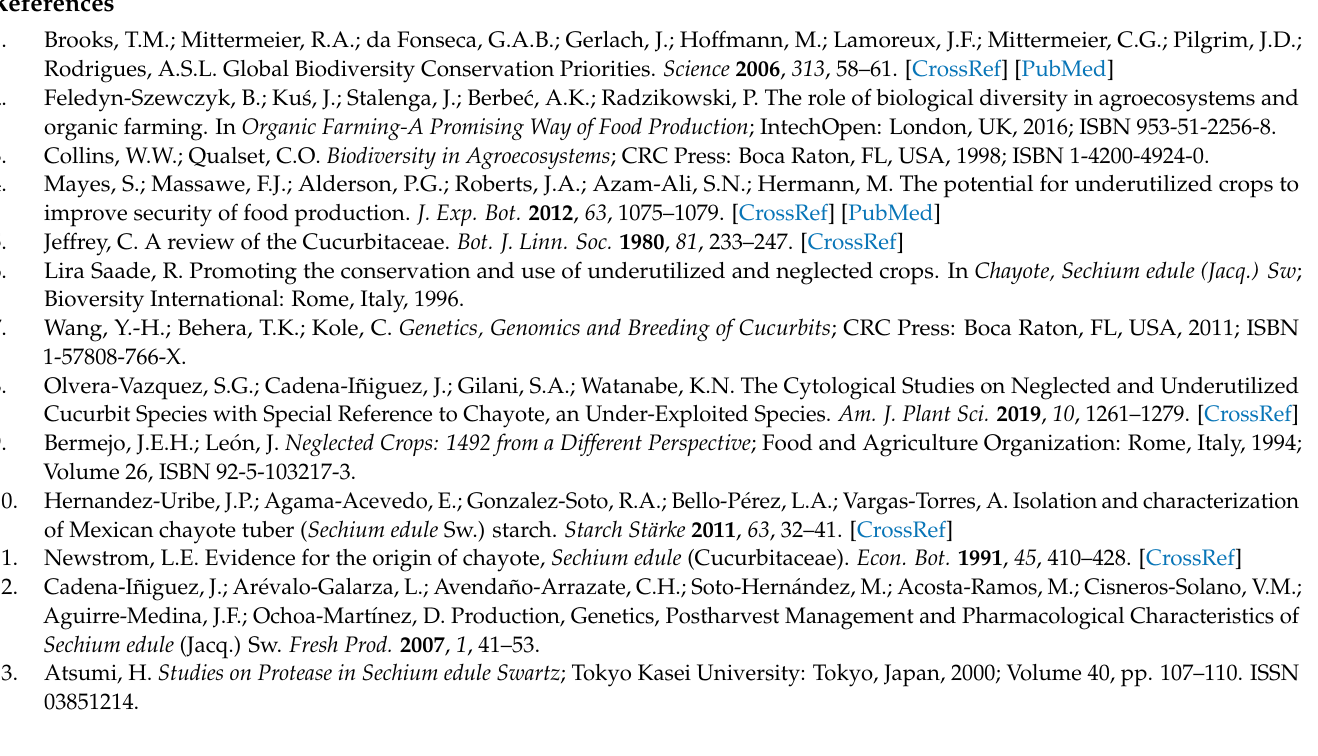
accessions; Figure S6: Delta K calculated by Structure Harvester using Evanno’s method; Figure S7: An example of PAGE genotyping results; Table S1: General description of fruit characteristics of five S. edule varietal groups; Table S2: Cytological characterization of Mexican and Japanese S. edule varietal groups; Table S3: Membership coefficient ( Q ); Table S4: Information of S. edule accessions used in current